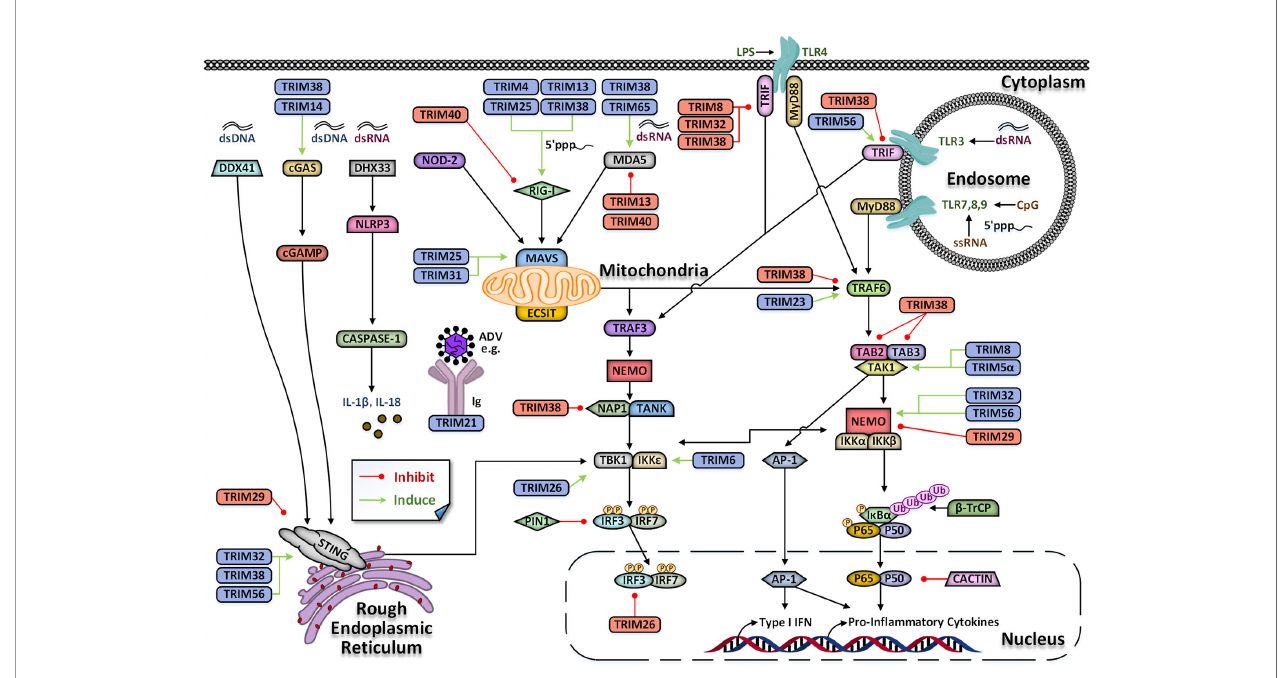
FIGURE 3 | TRIM-mediated regulation of innate immune signaling pathways. TRIM proteins play a dual role in antiviral immune signaling pathways indicated by black arrows. They could positively or negatively regulate antiviral immune signaling pathways, indicated by green arrows or red lines, respectively. Also, some TRAM proteins can act as common pathogen PRRs, or as cytosolic Fc receptors (such as TRIM21) to recognize non-enveloped viruses bound by immunoglobulin (Ig). DDX41, DEAD-box helicase 41; cGAS, cyclic GMP-AMP synthase; DHX33, DEAH-box helicase 33; NOD-2, nucleotide-binding oligomerization domain-containing protein 2; RIG-I, retinoic acid-inducible gene I; MDA5, melanoma differentiation-associated protein; TLR, Toll-like receptors; STING, stimulator of IFN genes; MAVS, mitochondrial antiviral signaling protein; TAK1, TGF- b -activated kinase 1; TAB2, TAK1/MAP3K7-binding protein 2; MyD88, Myeloid differentiation primary response gene 88; TRIF, TIR-domain-containing adapterinducing interferon- b ; NEMO, NF- k B essential modulator; NAP-1, nucleosome assembly protein; TNF, tumor necrosis factor; TRAF, TNF receptor-associated factors; TANK, TANK-binding kinase 1; I k B, inhibitor of NF- k B; IKK, I k B kinase; TBK1, TANK binding kinase 1; IFN, interferon; IRF, interferon regulatory factor; P, phosphorylation; Ub, ubiquitin; dsDNA, double-stranded DNA; dsRNA, double-stranded RNA; ssRNA, single-stranded; ADV, adenovirus; IL, interleukin; AP-1, activator protein-1; PIN1, Peptidyl-prolyl cis-trans isomerase NIMA-interacting 1; ECSIT, evolutionarily conserved signaling intermediate in Toll pathway; CASPASE-1, cysteinyl aspartate speci fi c proteinase 1; b -TrCP, b -transducinrepeats containing